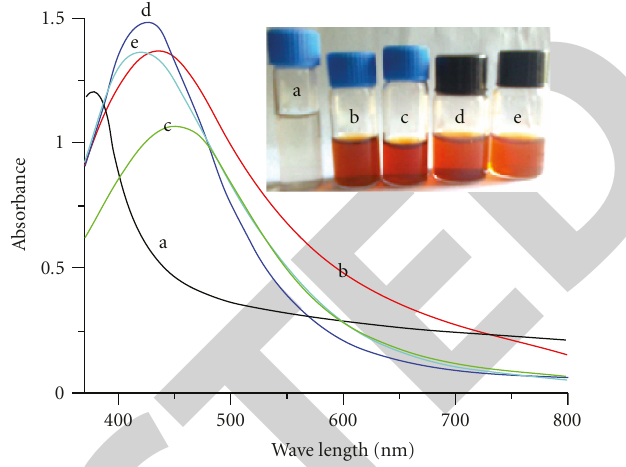
Figure 1: UV-vis absorption spectrum of (a) Polyalthia longifolia leaf extract, biosynthesized silver nanoparticles of di ff erent concen- tration (10 − 3 M and 10 − 4 M) at (b and d) 25 ◦ C, (c and e) 60 ◦ C.